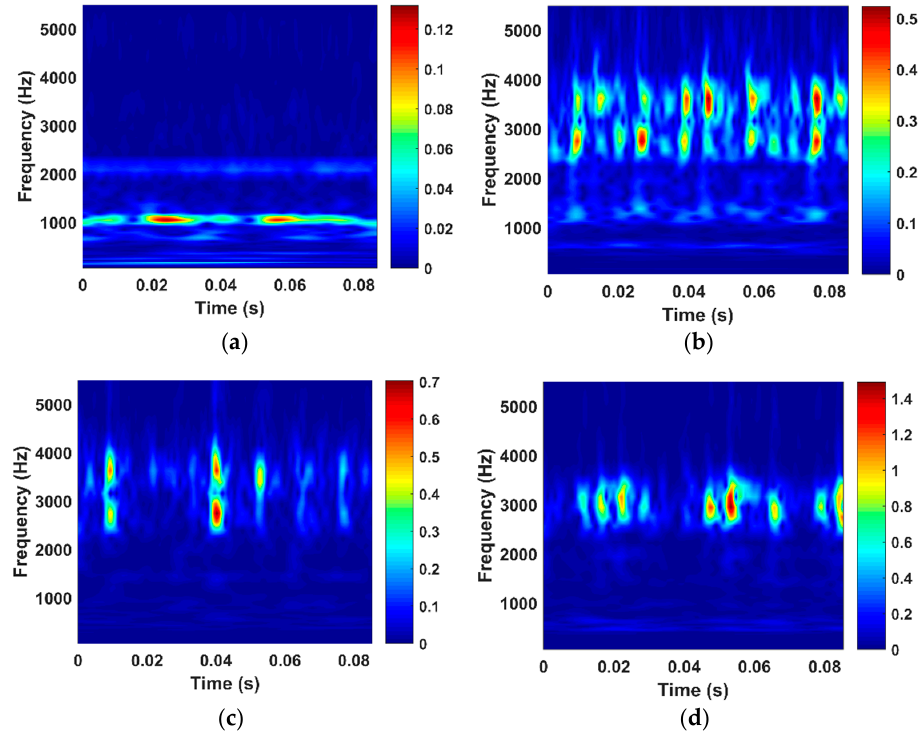
Figure 10. TFIs obtained using the WT from bearing vibration signals of different severity degrees: